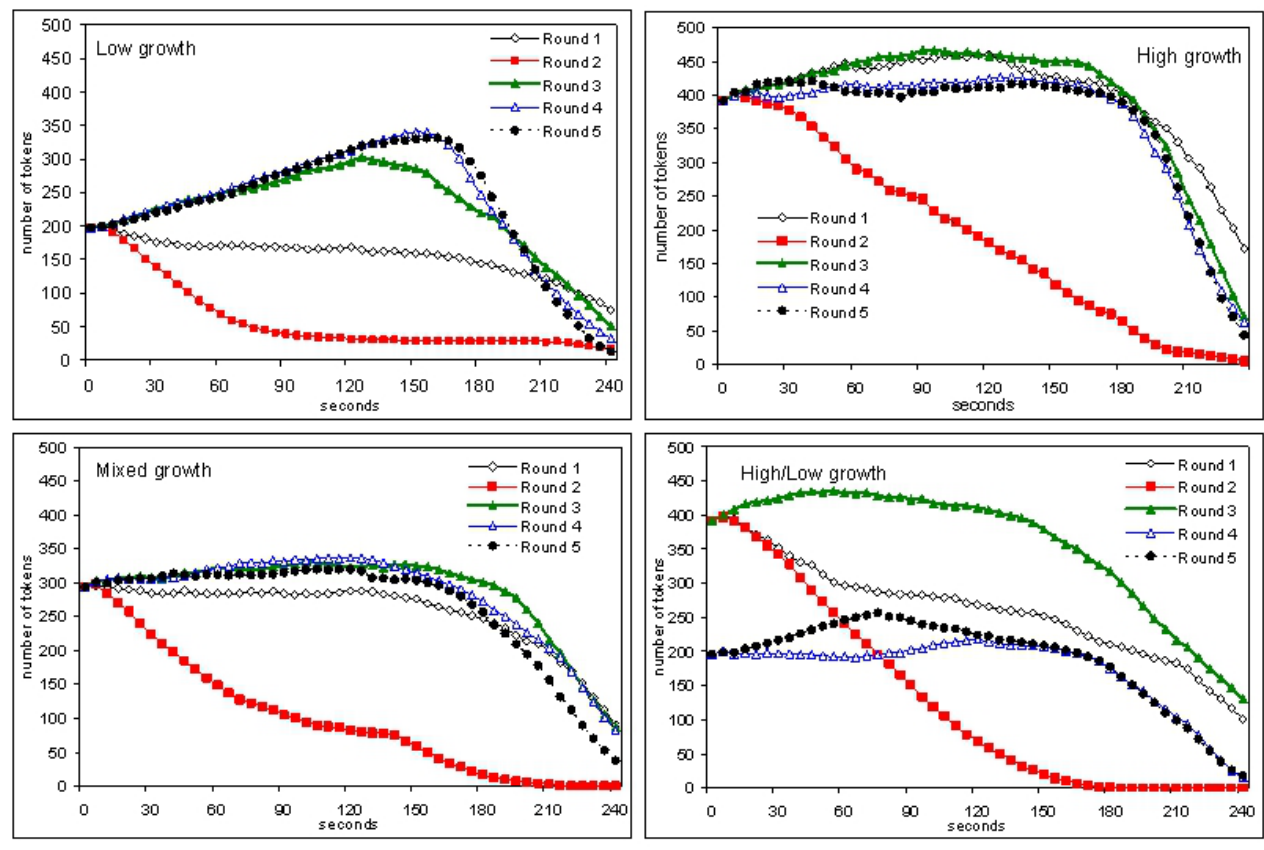
Fig. 3. Average number of tokens on the screen for the four different treatments and each